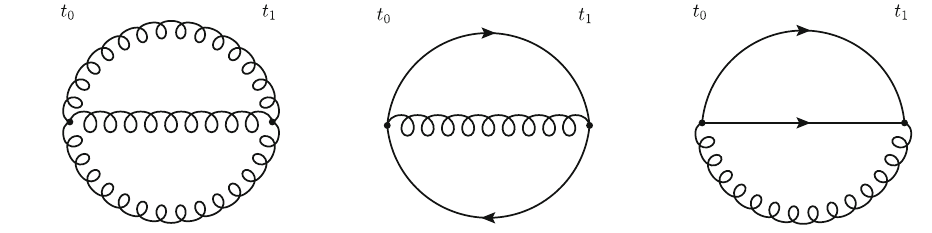
Fig. 2 Three of the considered colour-singlet medium correlators con- tributingtosplittingprocessesinthemedium.Alllinesrepresentdressed propagators resumming multiple scattering with the medium between time t 0 , corresponding to the time of splitting in the amplitude, and t 1 ,